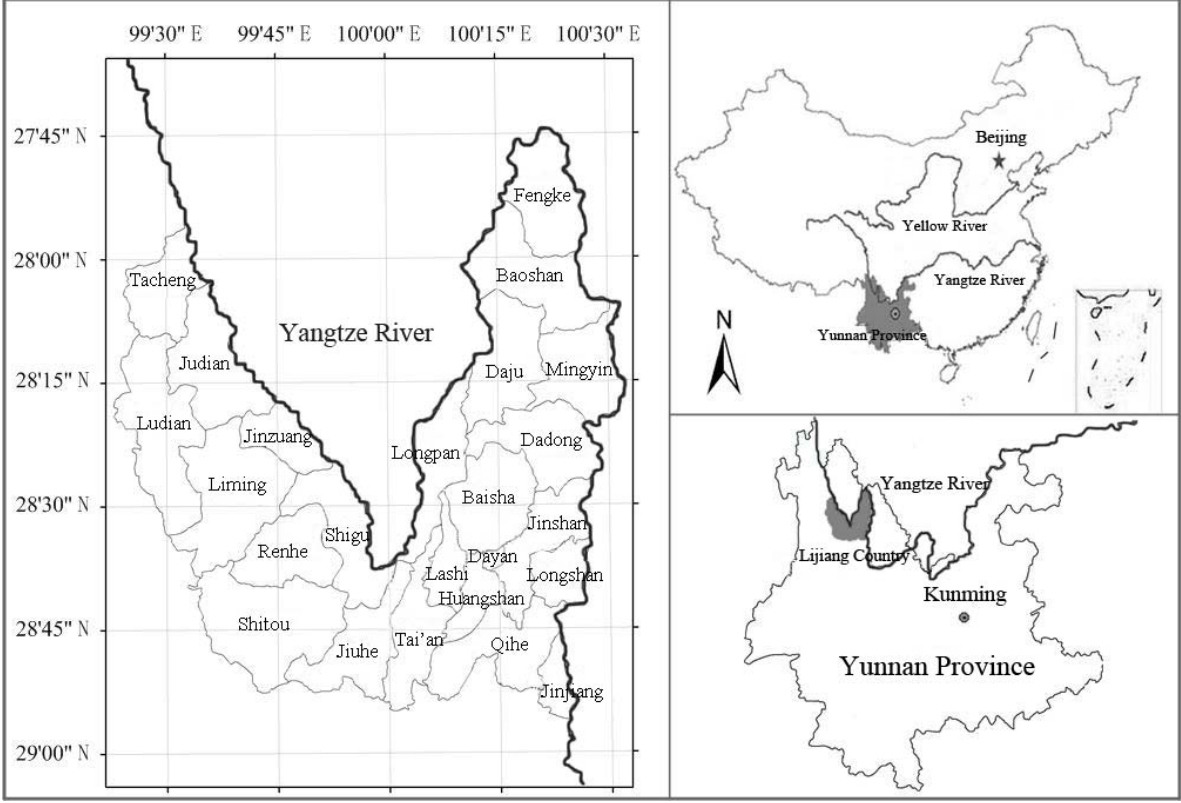
Figure 1. Location of the study area Lijiang County of Yunnan Province, P.R.